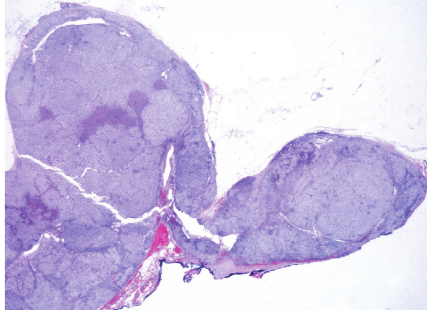
Figure 5: (H&E, original magnification x20)-The hyperplastic cortical fasciculata layer is characterized by a large number of cord organized cells with well-defined membranes, clear and vacuolated cytoplasm and, small nuclei.